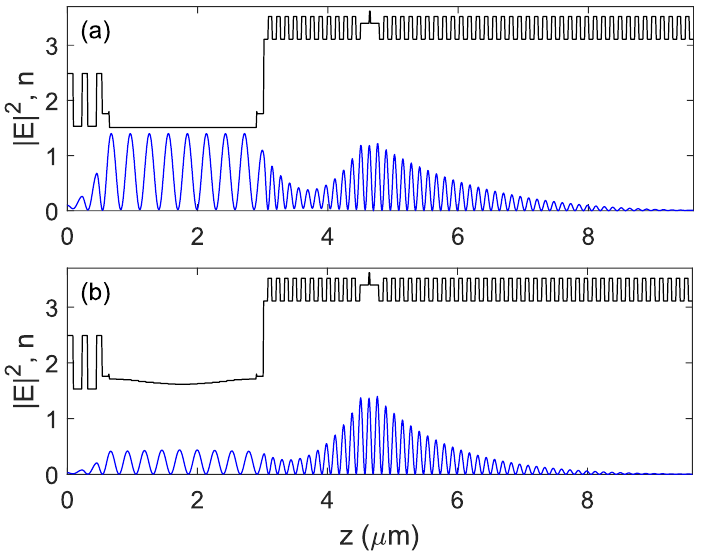
Figure 3. Optical power | E ( z ) | 2 distribution along the Oz axis of the LC-VCSEL resonant modes linearly polarized along the Ox ( a ) and along the Oy ( b ) direction. The voltage applied to the LC is U LC = 0.56 V. The black curves represent the refractive index distribution along the LC-VCSEL for the respective light